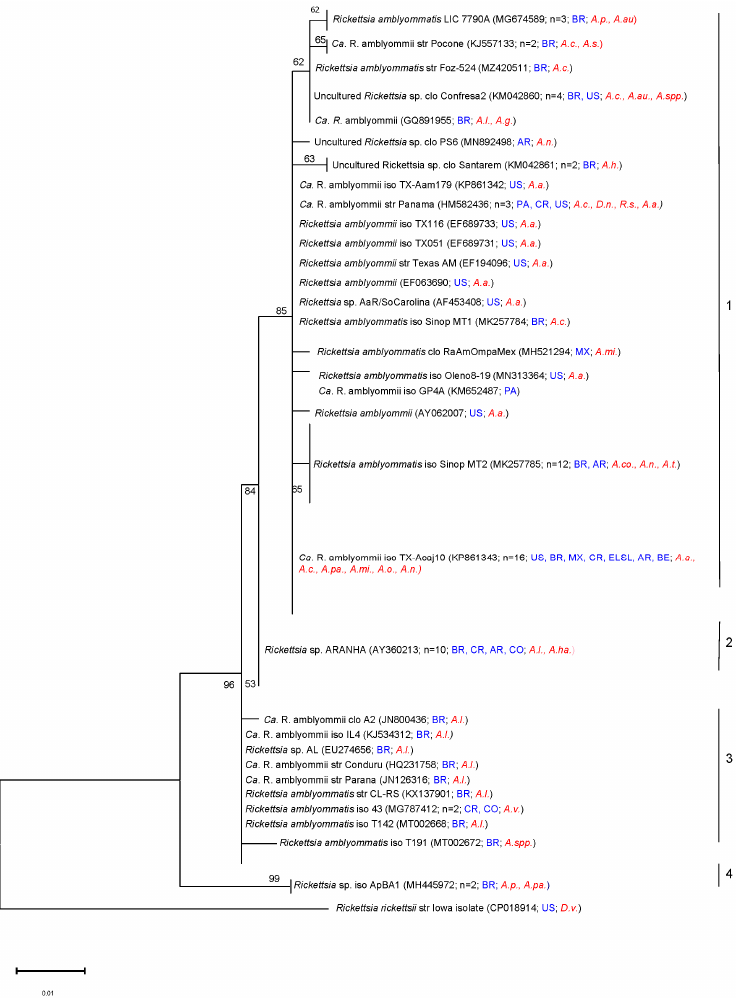
Figure 3. Phylogenetic tree of published sequences and reports of Rickettsia amblyommatis in ticks. The analyses were based on the sequences of the ompA gene region of Rickettsia amblyommatis within 406 bp obtained from NCBI BLAST. This tree shows a collapsed version incorporating a total of 79 nucleotide sequences (n shows the total number of sequences included in that group). The phylogenetic analysis was completed using a maximum likelihood method on the Kimura 2-parameter model (ML; bootstrap replicates: 1000). This tree is collapsed with nodes organized by sequence differences of 0.001. Instances in which publications reported the species as “ Rickettsia spp.” but indicated in the publication that the species was R. amblyommatis were included in this analysis. The GenBank accession numbers are given in parentheses. Scale bars indicate the number of substitutions per nucleotide position. The Rickettsia rickettsii Iowa isolate (CP018914) was included as an outgroup. Tick species included in this tree are as follows: A auricularium (A.au.), A. cajennense (A.c.), A. coelebs (A.co.), A. geayi (A.g.), A. hadanii (A. ha.), A. humerale (A.h.), A. longirostre (A.l.), A. ameri-